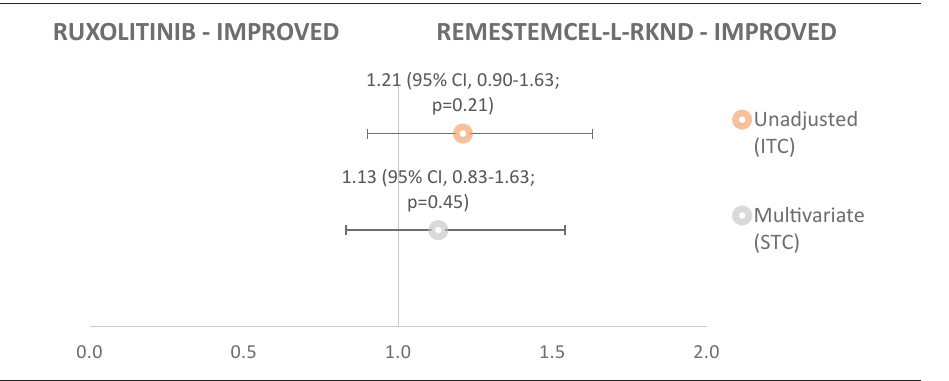
Figure 2. Risk Ratio for Day 28 ORR of Remestemcel-L-rknd (N=55) Versus Ruxolitinib